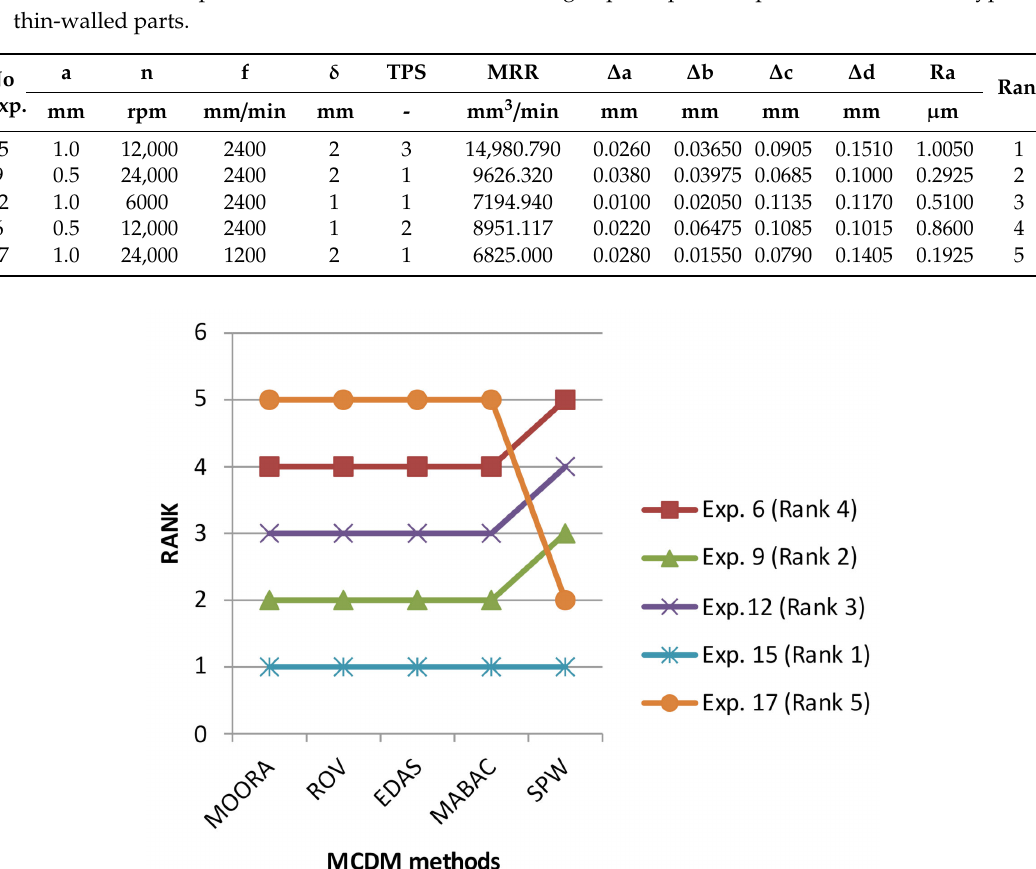
Figure 7. Ranking chart of the 5 best alternative experiments for the selected MCDM